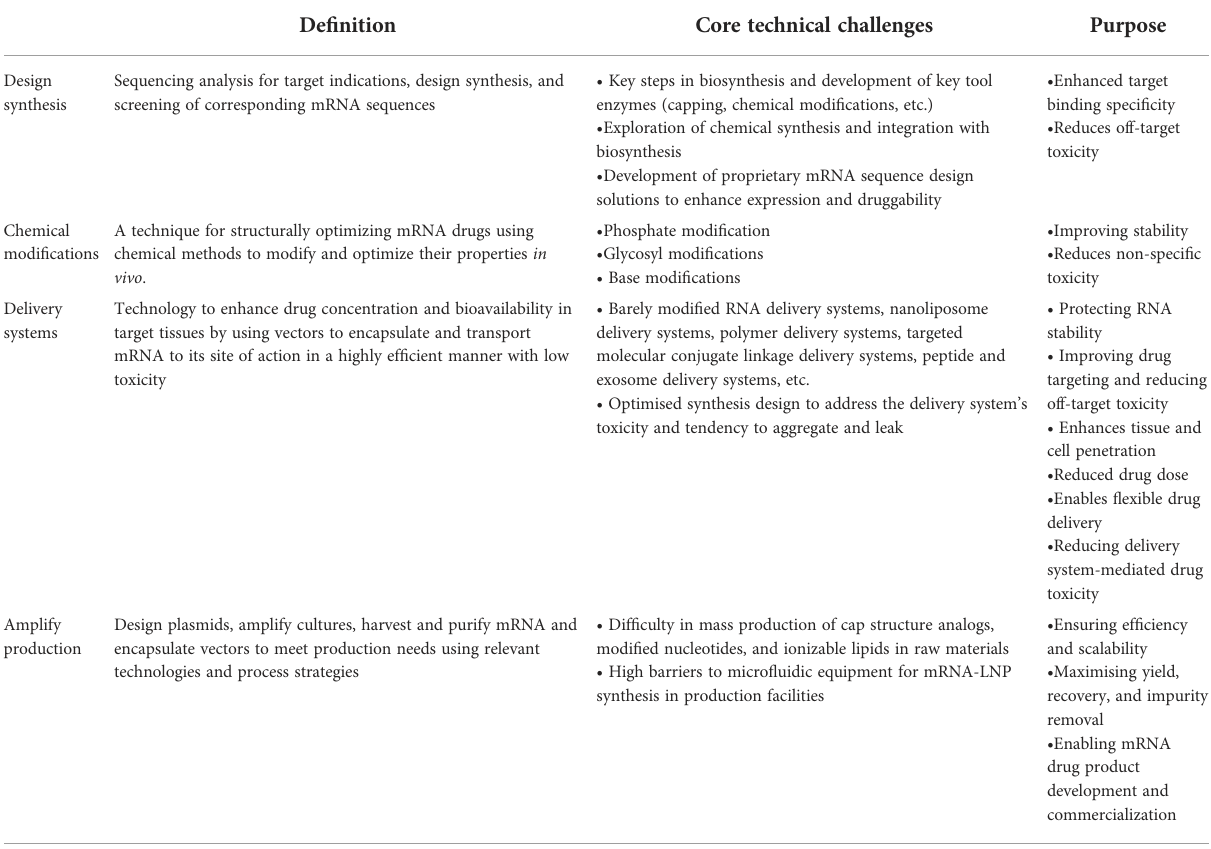
TABLE 3 Core technical challenges in the development of mRNA drugs.